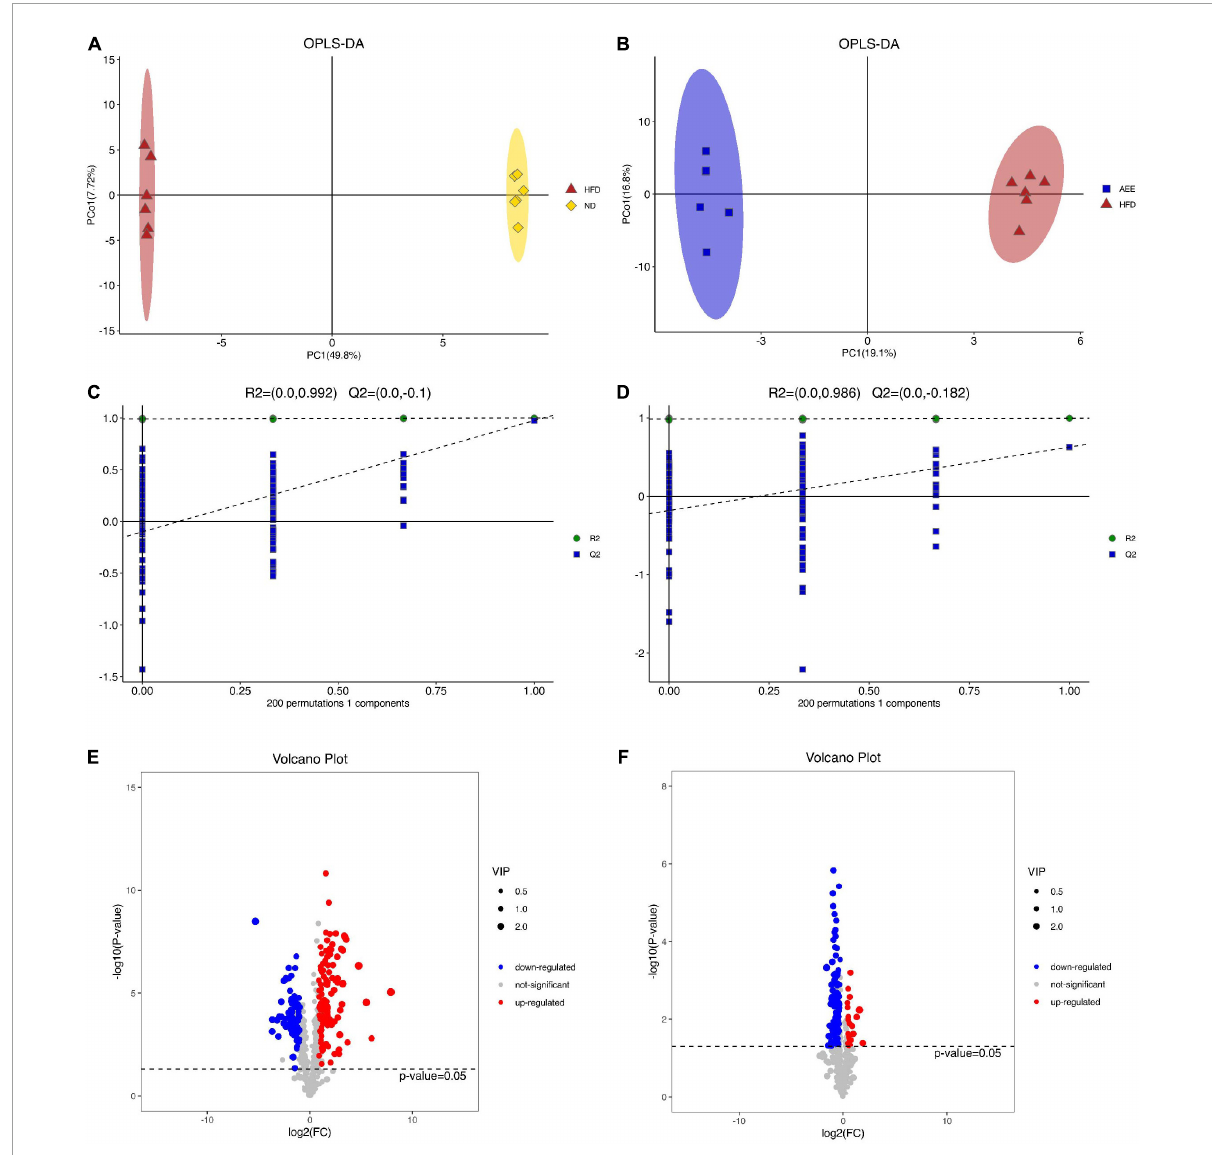
FIGURE3 OPLS-DA and volcano plot analysis of lipid in the liver. (A) OPLS-DA analysis in HFD vs. ND. (B) OPLS-DA analysis in AEE vs. HFD. (C) OPLS-DA displacement test of HFD vs. ND (Q2 = –0.1). (D) OPLS-DA displacement test of AEE vs. HFD (Q2 = –0.182). (E) Volcano plot of differentially lipids in HFD vs. ND. (F) Volcano plot of differentially lipids in AEE vs. HFD. Red dots represent significantly upregulated lipids and blue dots represent significantly downregulated lipids. Lipids that are not significant are represented by gray